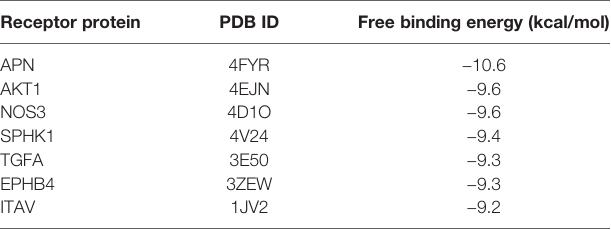
TABLE 1 | Molecular docking with free energy − 9.0 kcal/mol and below as the high af fi nity standard screened out seven optimal binding proteins. Receptor